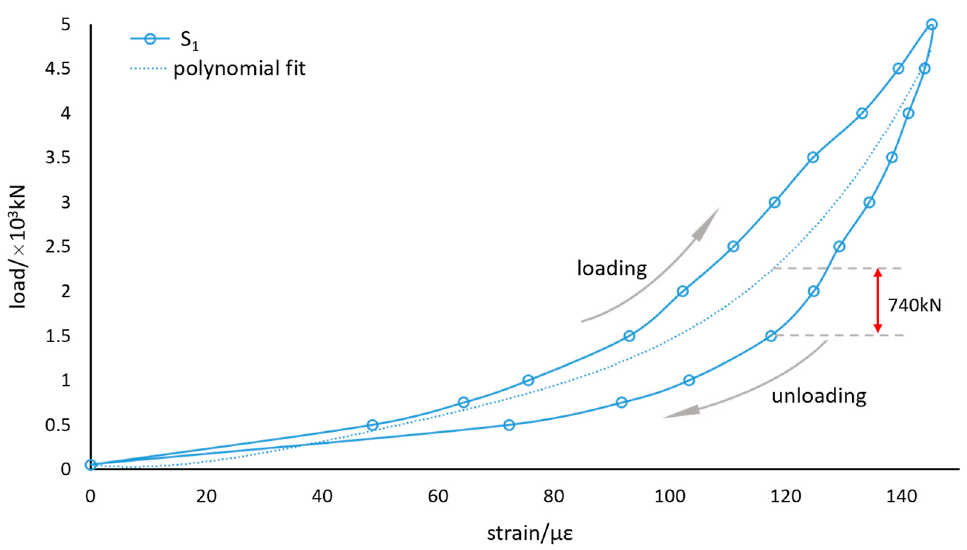
Figure 9. Polynomial fitting of the load-strain relationship.